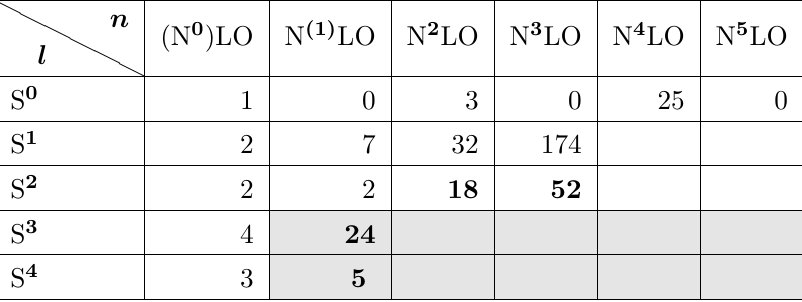
Table 1 . The number of highest-loop graphs in the worldline picture contributing to each sector in the state-of-the-art of PN gravity for the orbital dynamics of compact